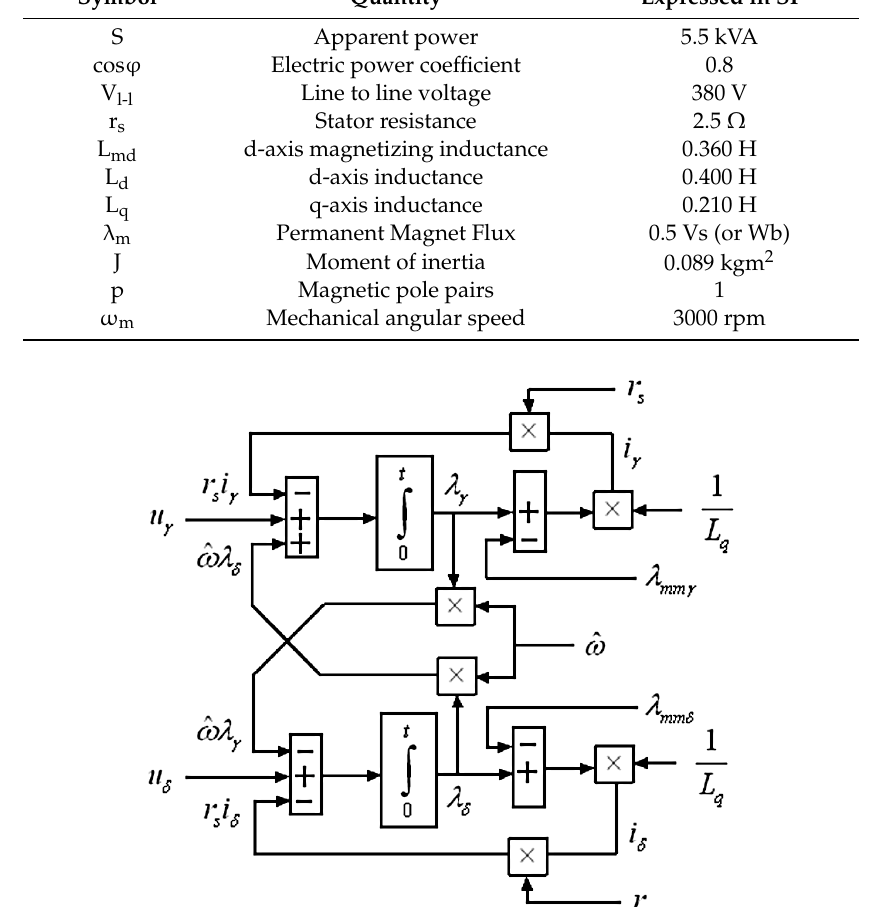
Table 1. Parameters of Permanent Magnet Synchronous Machine (PMSM).